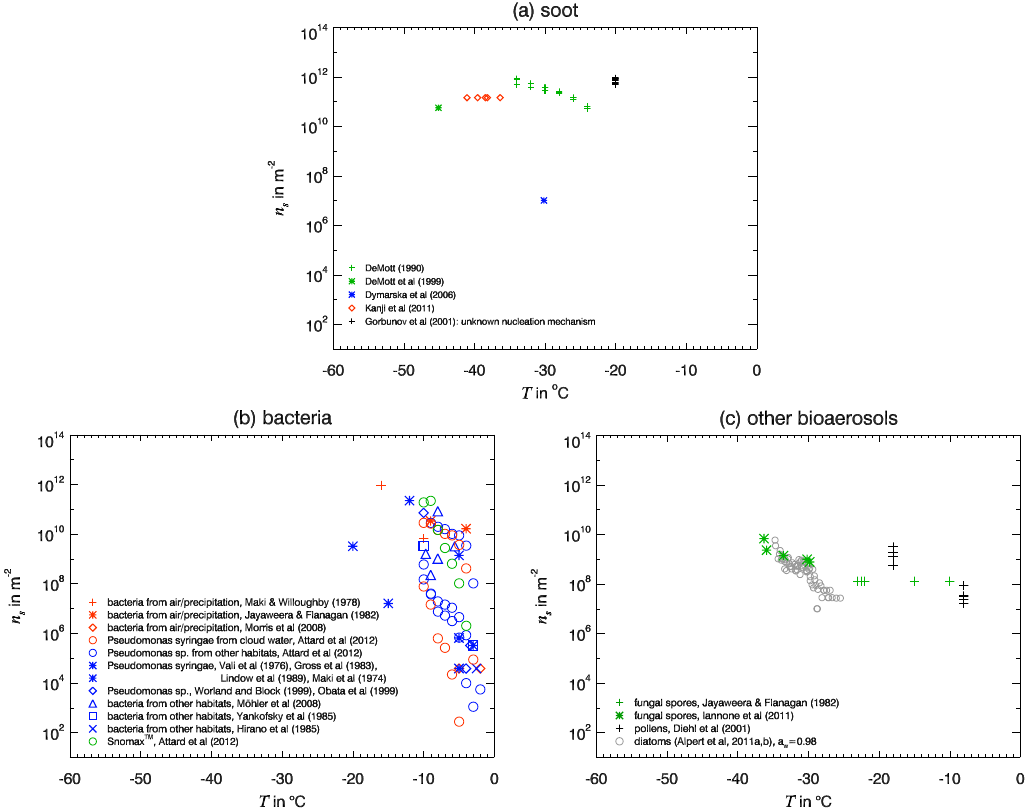
Fig. 12. INAS densities for soot and bioaerosols for immersion freezing, including deposition/condensation freezing experiments at or above water